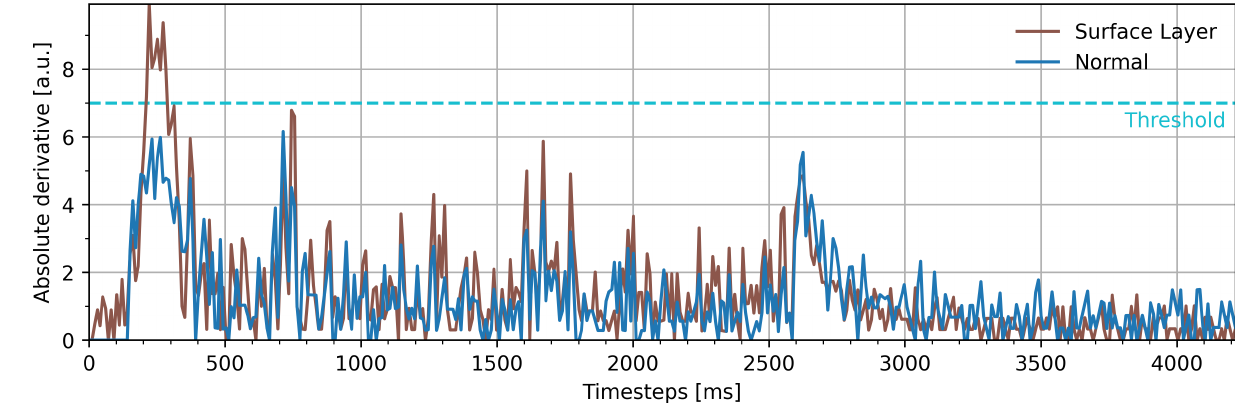
Figure 12. Absolute normalised derivative of the temperature evolution of an area with detected surface layers and a normal